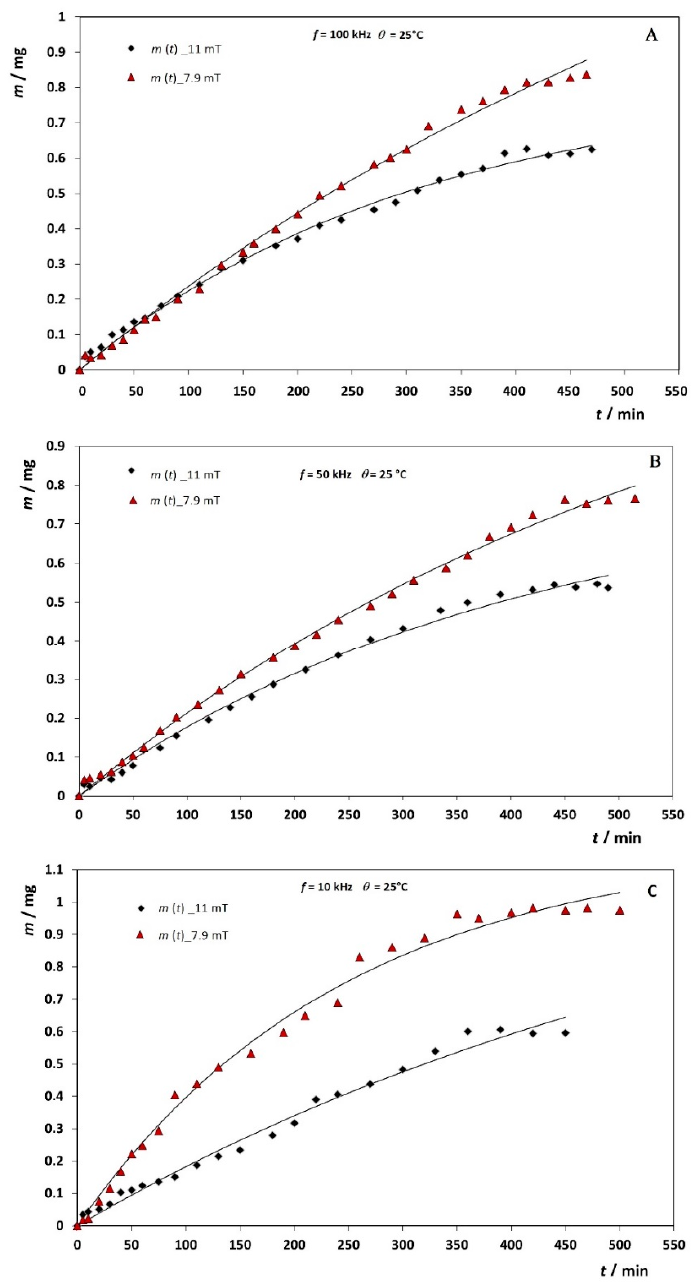
Figure 9. The representative cumulative release profiles for the quercetin from MNPs through dialysis membrane at 25 ◦ C using two stationary magnetic fields and three different frequencies of alternating magnetic field ( A ) 100 kHz, ( B ) 50 kHz and ( C ) 10 kHz.